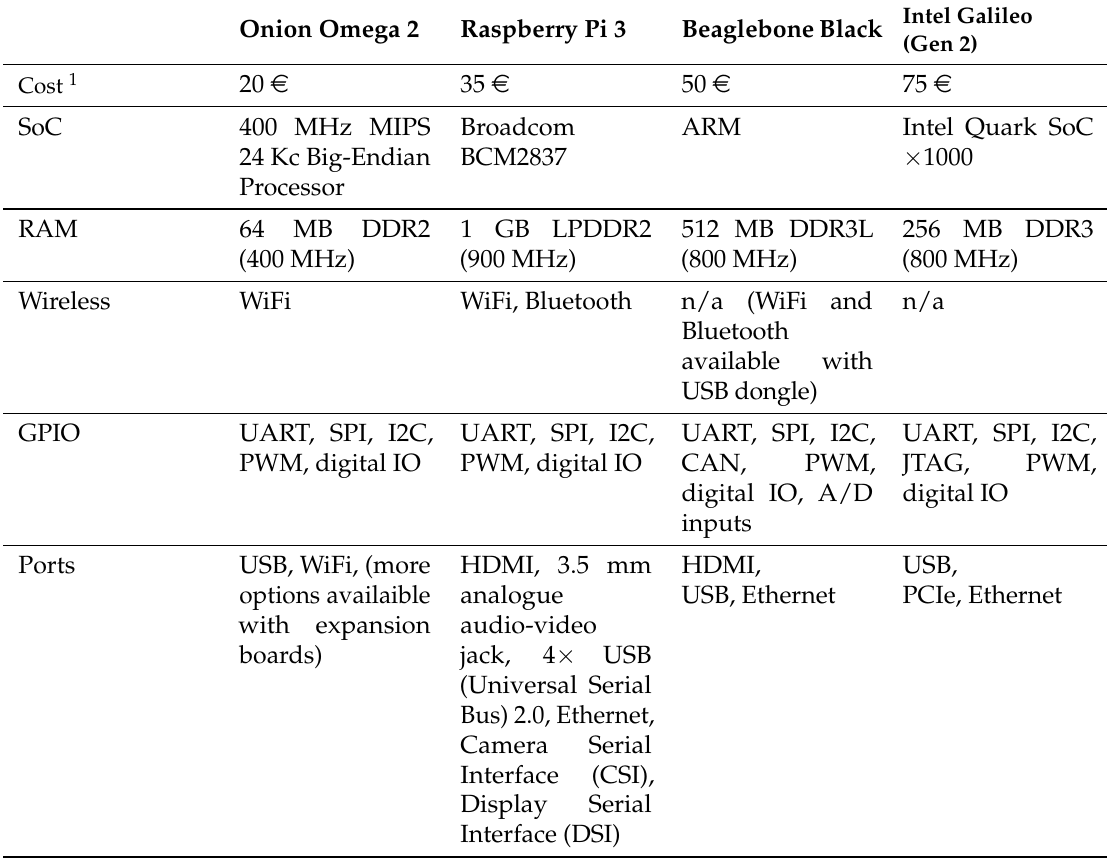
Table 1. Comparison of low-cost development